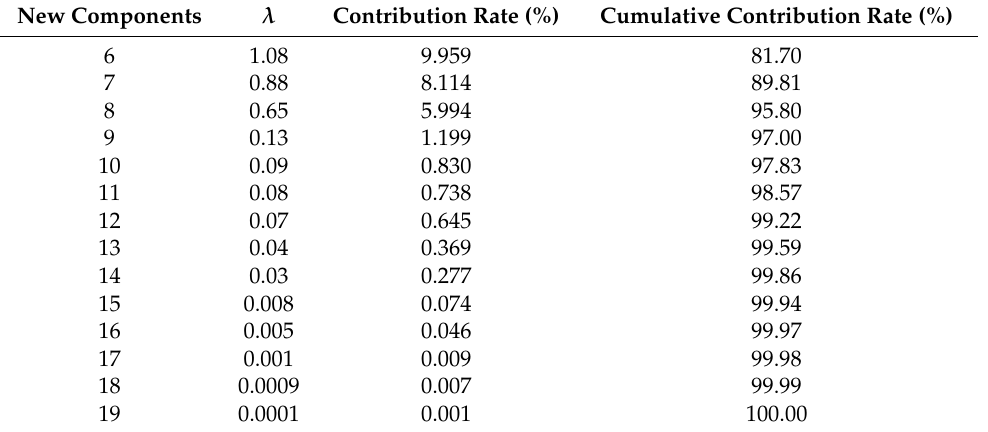
Table 3. λ and contribution rate of each new component.